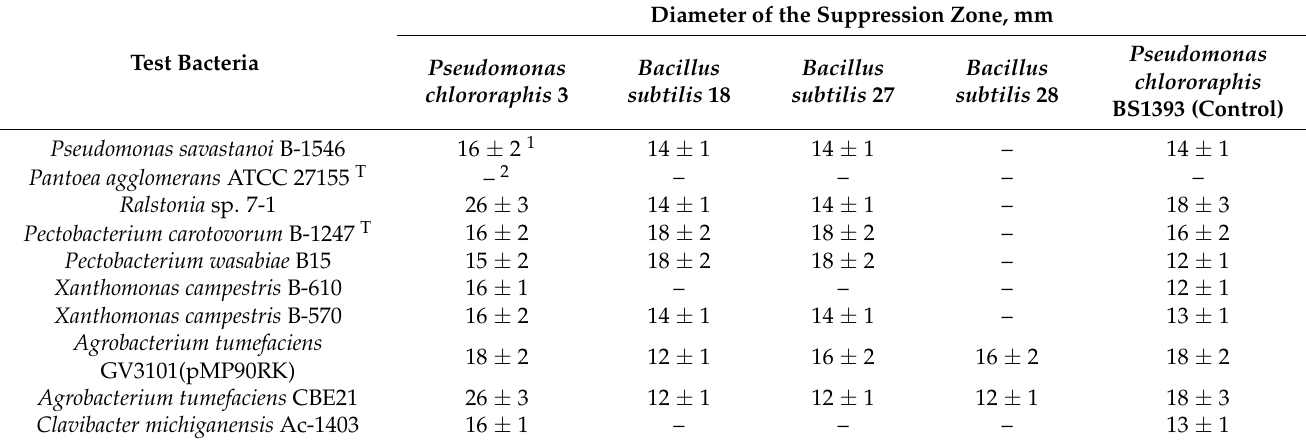
Table 2. Antibacterial activity of the soil strains.